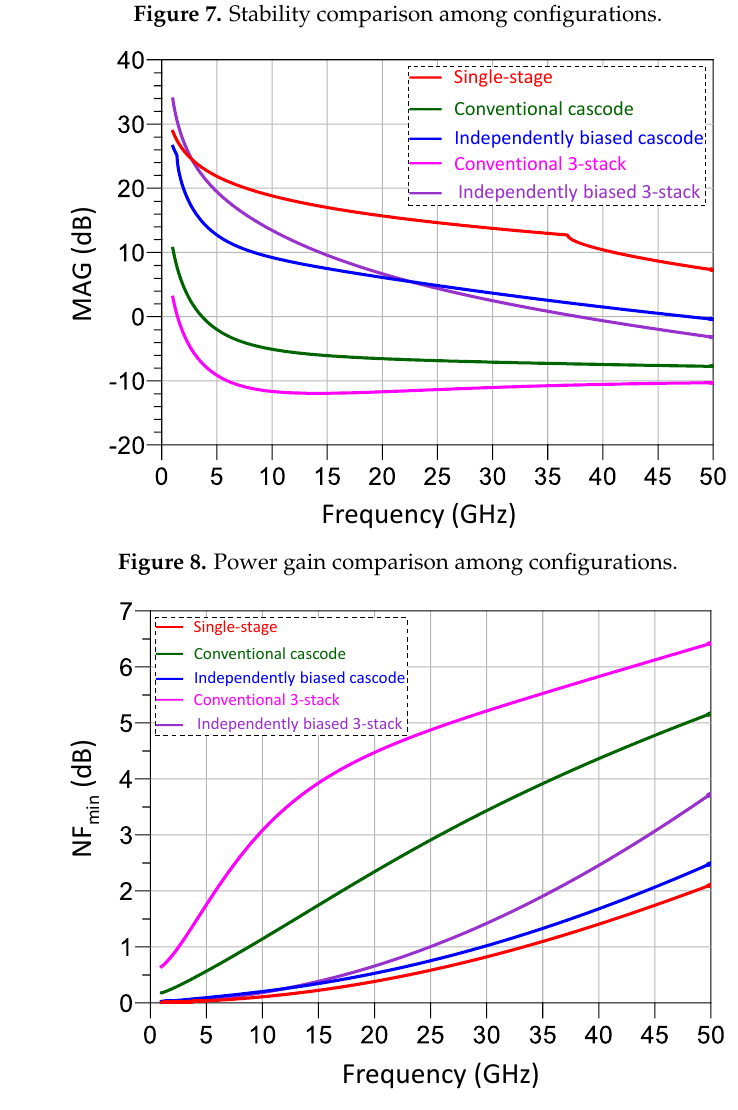
Figure 9. Noise figure comparison among